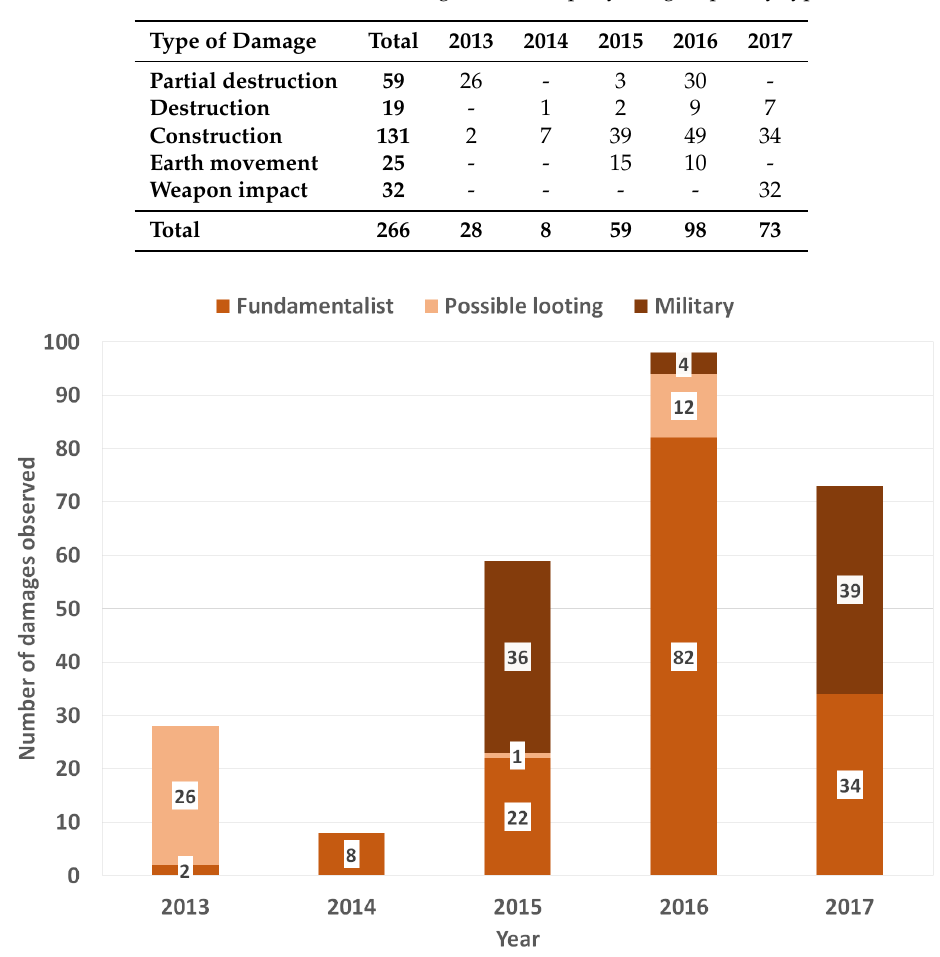
Table 5. Distribution of the damage (total and per year) grouped by type.